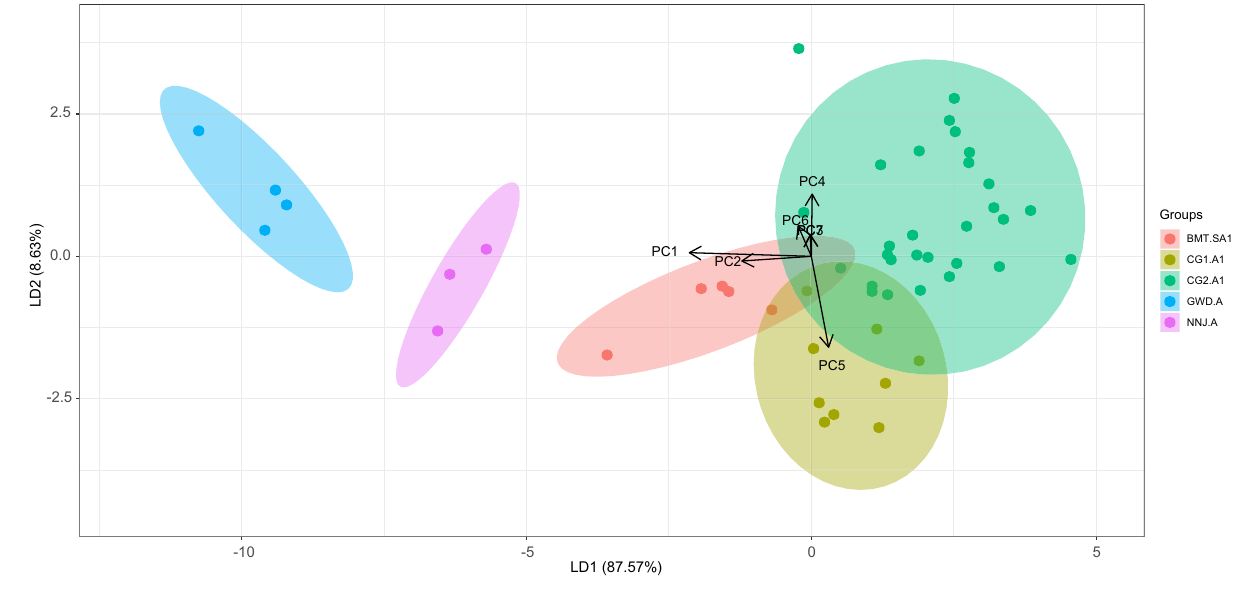
Figure 4. Figure showing a two-dimensional plot of discriminant function analysis using LD1 (Linear Discriminant) and LD2. Each colour represents each wolf. 100% accuracy was achieved in identifying 49 howls from five Indian